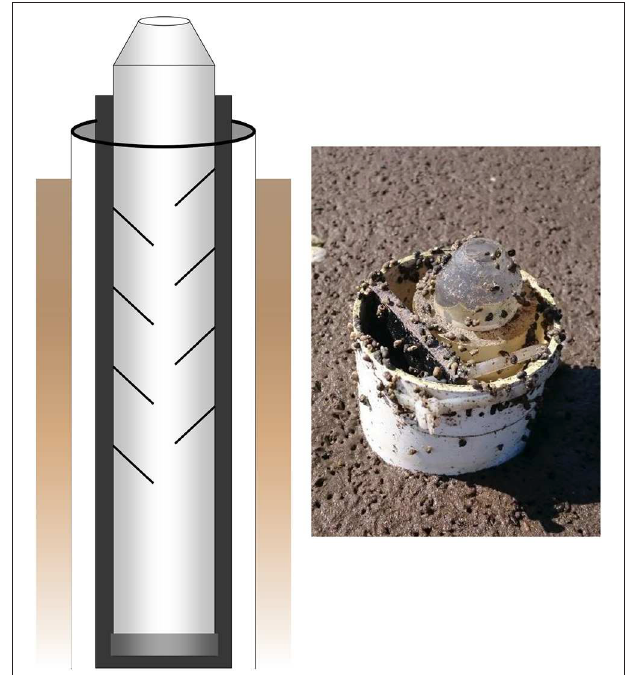
FIGURE 3 | The settlement trap with internal baffles and conical opening. The column is attached to a backing plate (black). In the field this was placed into the sediment, sitting within the illustrated support